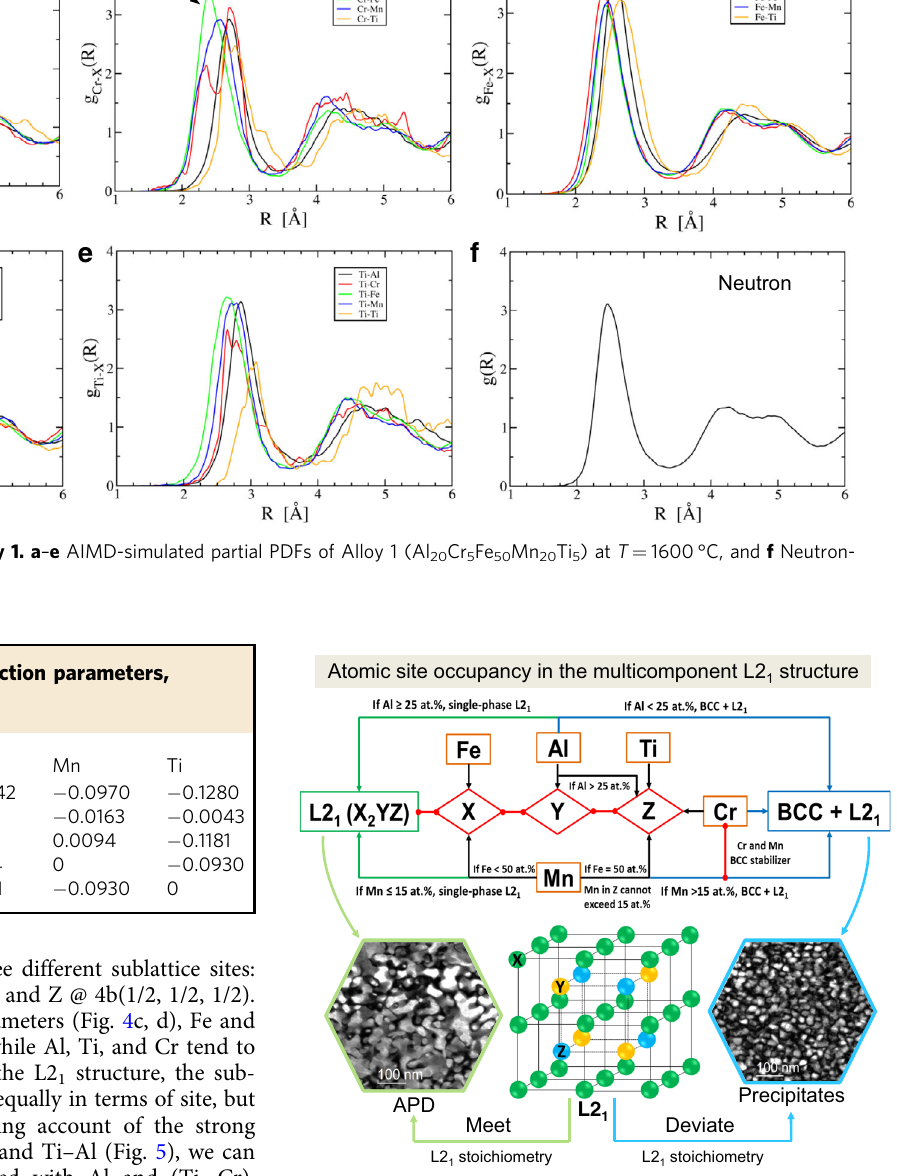
Fig. 6 Schematic of the atomic-site occupancy and morphology evolution of the L2 1 structure. A schematic showing the atomic-site occupancy in the multicomponent L2 1 structure and the morphology evolution of the L2 1 phase that depends on the chemical compositions of discovered